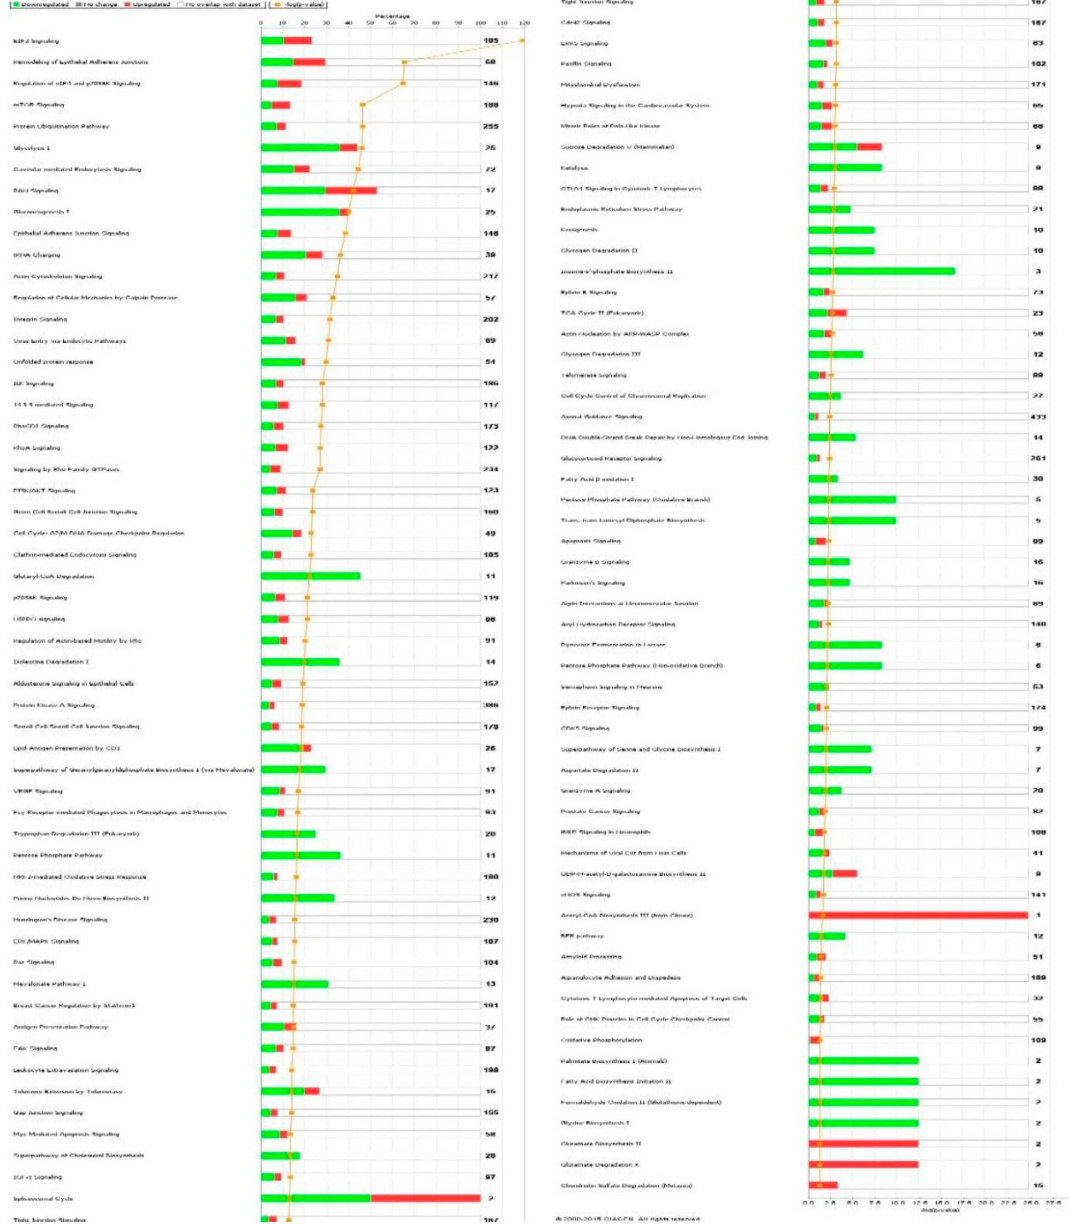
Figure 1. Proteomic analysis revealed molecular interactome regulated by vancomycin in HK-2 cells. HK-2 cells were treated with 50 µ g/mL vancomycin for 24 h and the protein samples were subject to quantitative proteomic analysis. There were 290 related pathways regulated by vancomycin in HK-2 cells. Red indicates an up-regulation; green indicates a